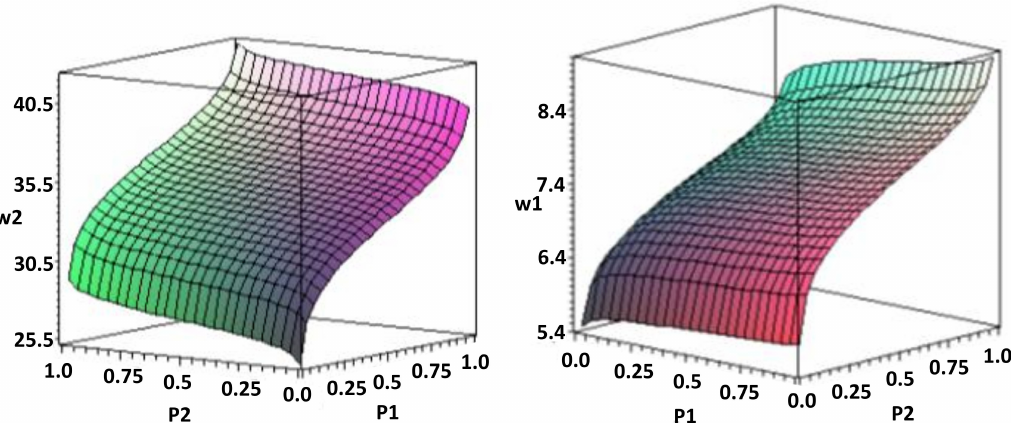
Figure 3. Evolution of circular natural frequencies ω 1 and ω 2 versus the probabilities P 1 and P 2. Case 2: The stiffnesses are possibilistic